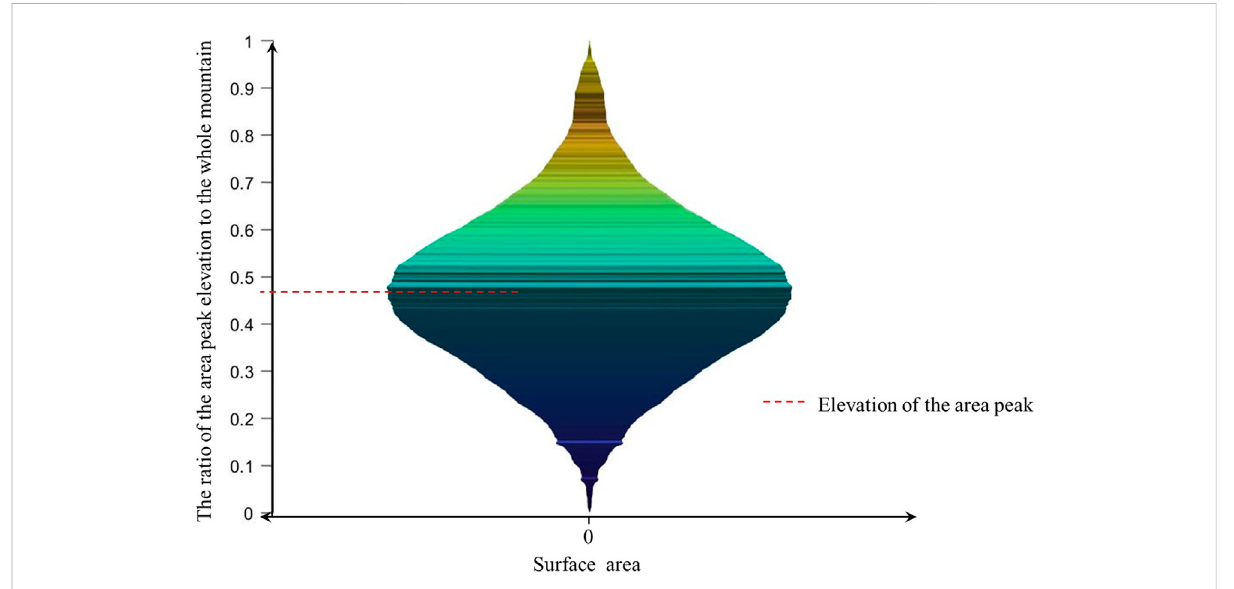
FIGURE 3 Model of the relationship between the mountain surface area and